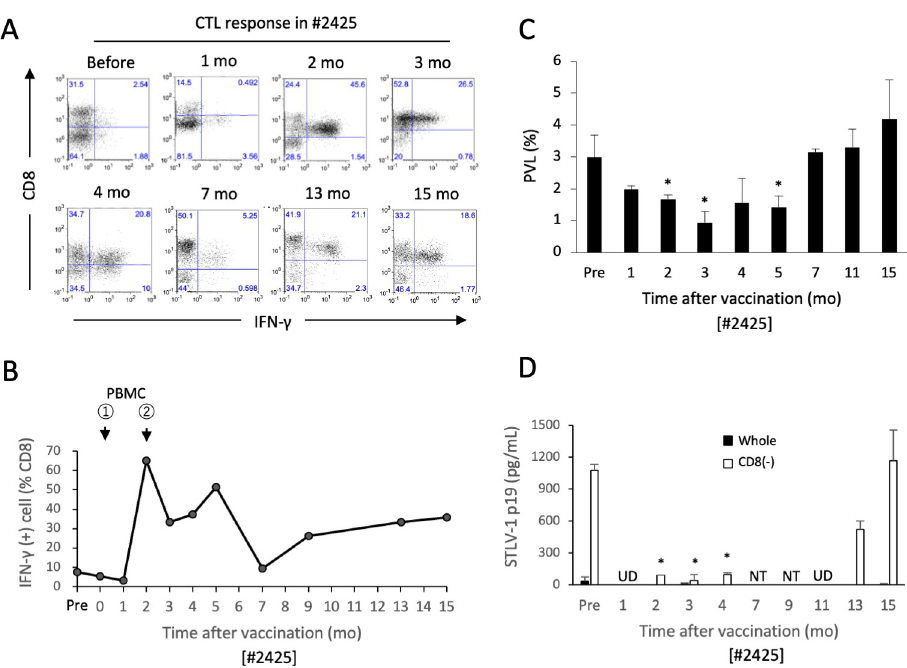
Fig 6. Vaccination of monkey #2425 with autologous PBMCs. Monkey #2425 was subcutaneously inoculated twice with 3 × 10 6 MMC-treated autologous CD8 + cell-depleted PBMCs that had been cultured for 3 days, with doses spaced 2 months apart. A, B. CTL responses against ILT-2425 in PBMCs were analyzed by cytokine flow cytometry as described in the Methods, and the representative results at the indicated time points after vaccination ( A ) and the kinetics of the STLV-1-specific CD8 + CTL response ( B ) are shown. The arrows indicate the time points of vaccination. C. STLV-1 PVLs in the #2425-PBMCs at the indicated time points are shown as the mean and SD of triplicate samples. D. Unfractionated (closed bar) or CD8 + cell-depleted (open bar) #2425-PBMCs were cultured for 7 days, and the STLV-1 p19 concentrations in their supernatants were measured by ELISA. The values indicate the mean and SD of duplicate samples. � p < 0.05. U.D., undetectable. N.T., not